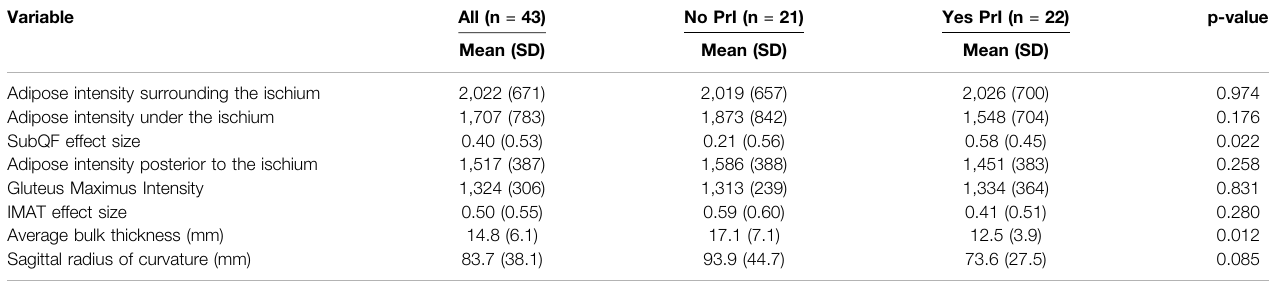
TABLE 2 | Adipose characteristics.